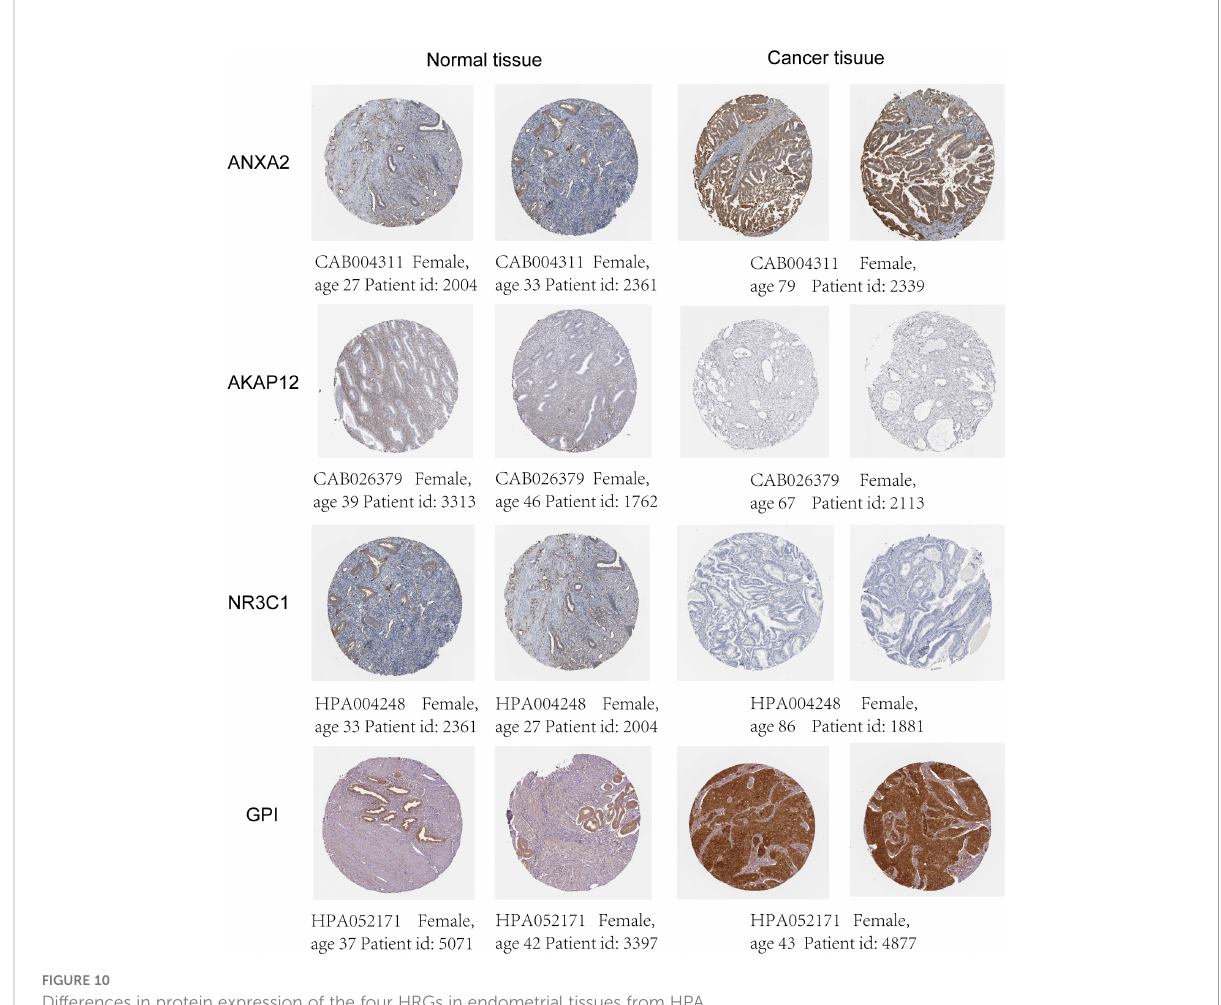
FIGURE 10 Differences in protein expression of the four HRGs in endometrial tissues from HPA.